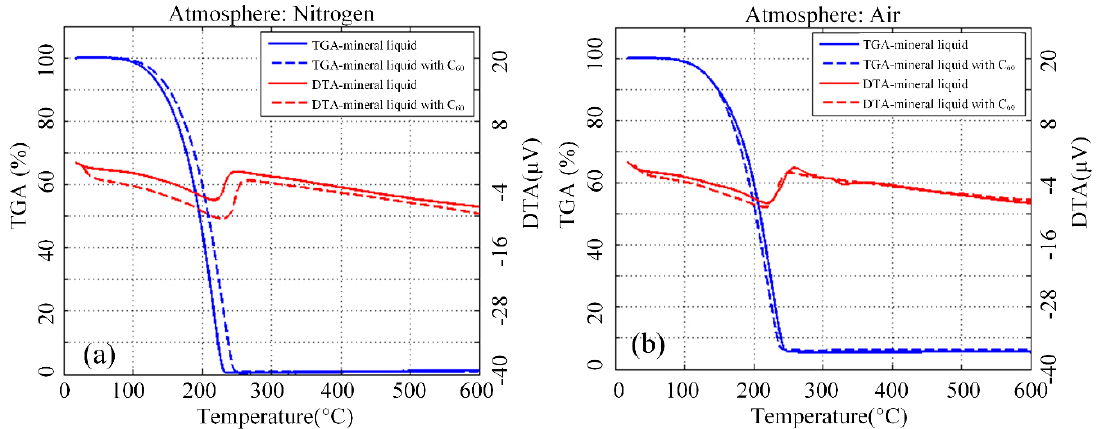
Figure 10. TGA and DTA curve of C 60 modified mineral insulating liquid and pure sample nitrogen ( a ) and air ( b ) atmosphere.